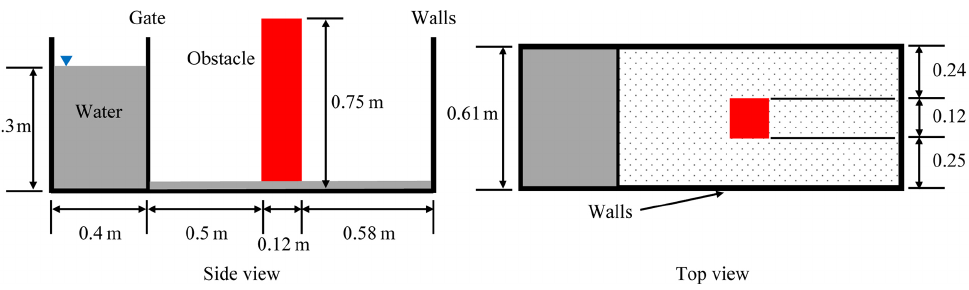
gate were controlled by the GMO module; specifically